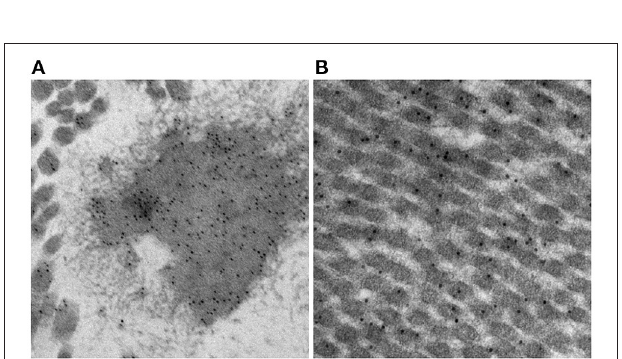
FIGURE 3 | In vitro evidence of post-implant rabbit sera specificity to elastin (A) and collagen (B) in GA fixed (0.2%) porcine aortic wall using gold-labeled